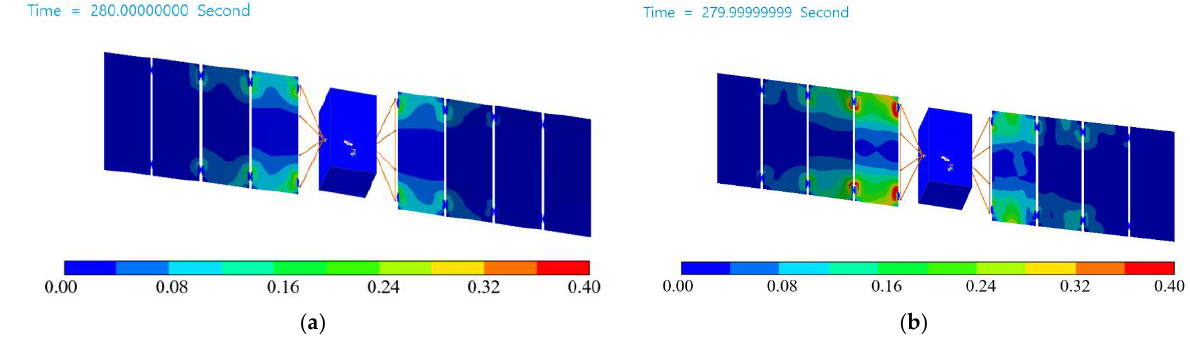
Figure 14. Stress contour of panels in orbit maneuver: ( a ) by FEM; ( b ) by